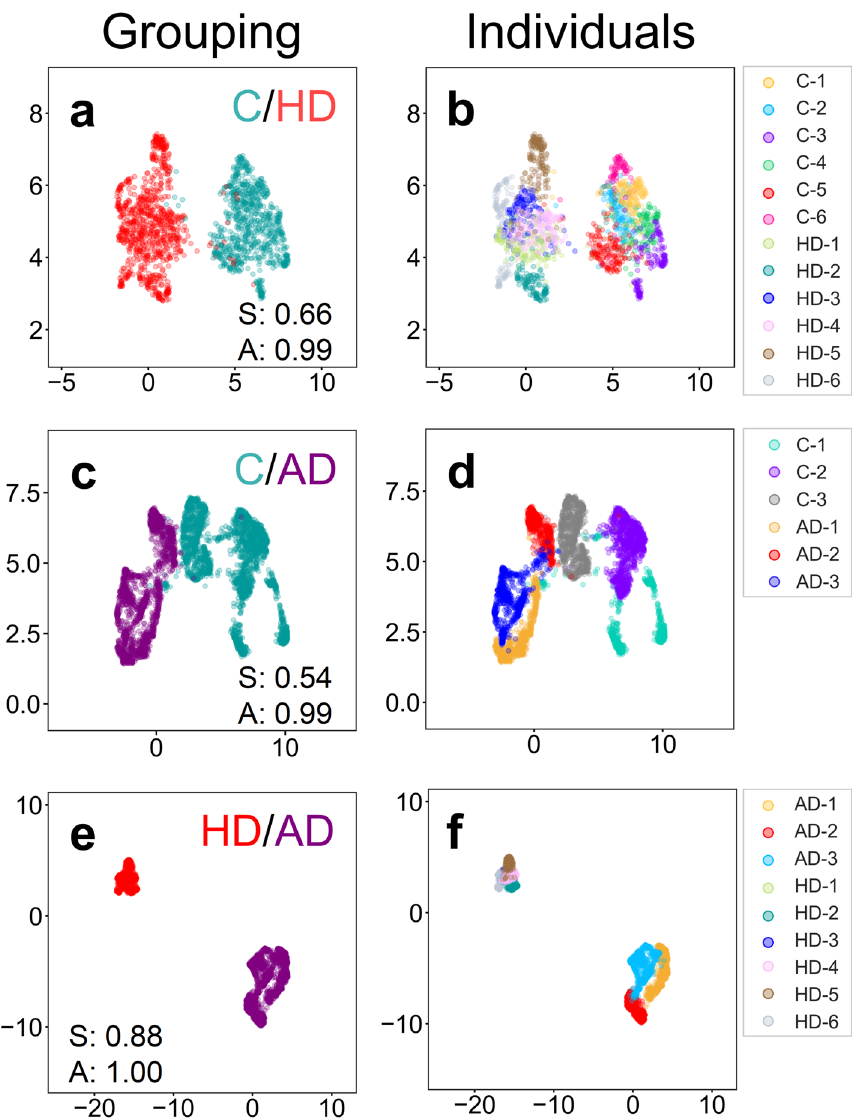
Figure 8. Spectral phenotyping can predict human neurodegenerative disease class from fibroblasts. FTIR spectra from human skin fibroblasts of controls (C) versus Huntington’s disease (HD, a , b ), Alzheimer’s disease (AD, c , d ) or a comparison of HD and AD ( e , f ) were evaluated by UMAP. The UMAP plots are the results of either pooled control or pooled disease samples ( a , c , e ), or displayed per individuals ( b , d , f ). All UMAP analyses were performed on 2 nd derivative normalized FTIR spectra of whole cells. S, silhouette score ( p value < 0.001); A,